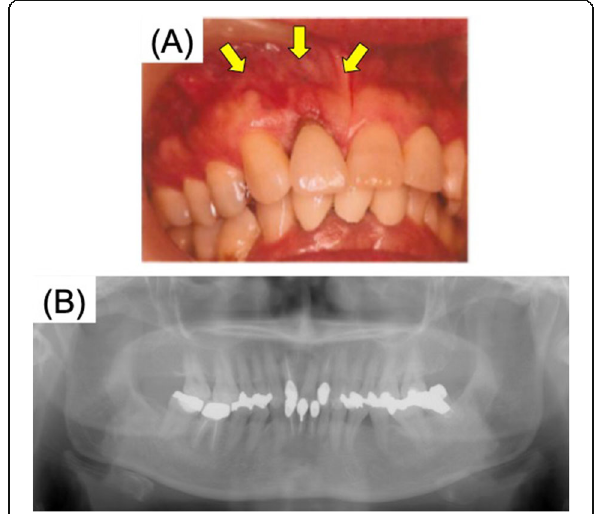
Fig. 1 First examination showing swelling (arrow) diagnosed as gingival SCC of the maxilla. a Intraoral findings. b Preoperative radiograph. SCC, squamous cell carcinoma